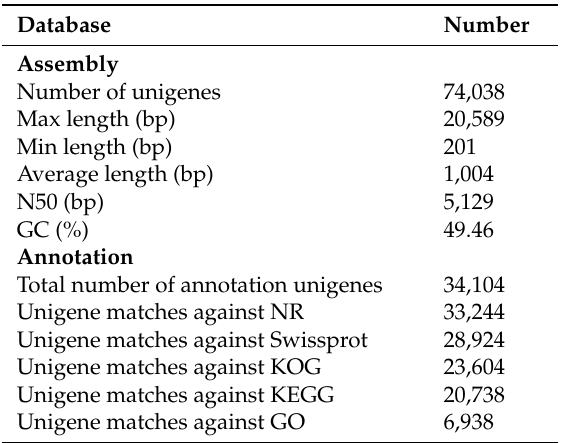
Table 2. S. sihama gonads transcriptome reference assembly and annotation